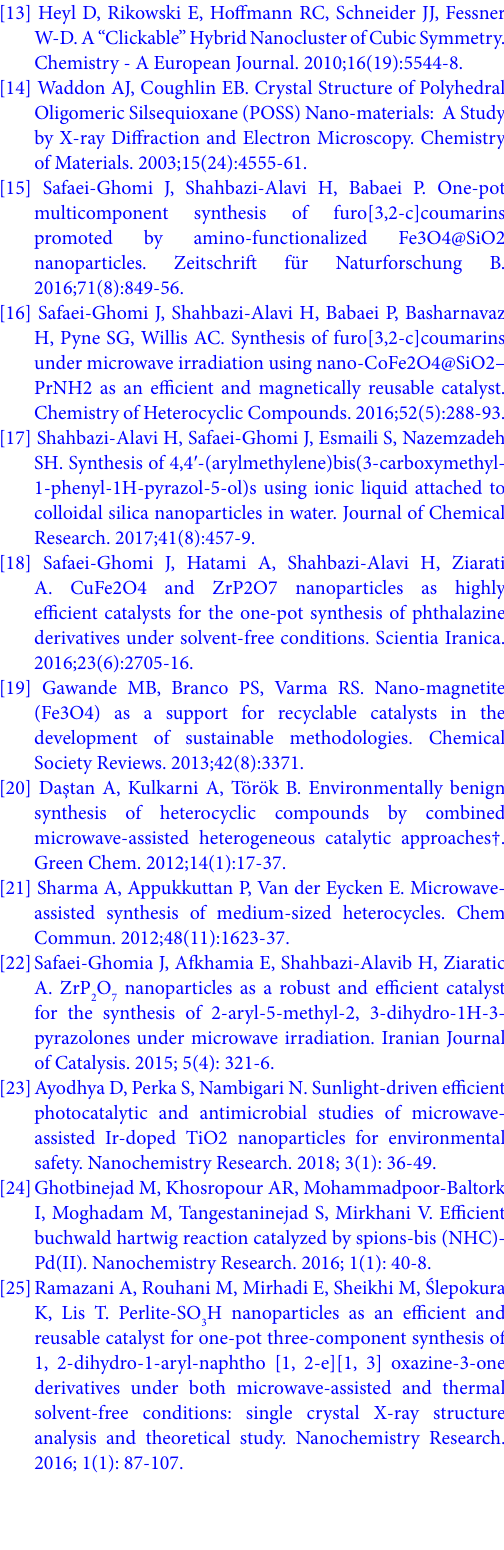
19 Nanochem Res 4(1): 11-19, Winter and Spring